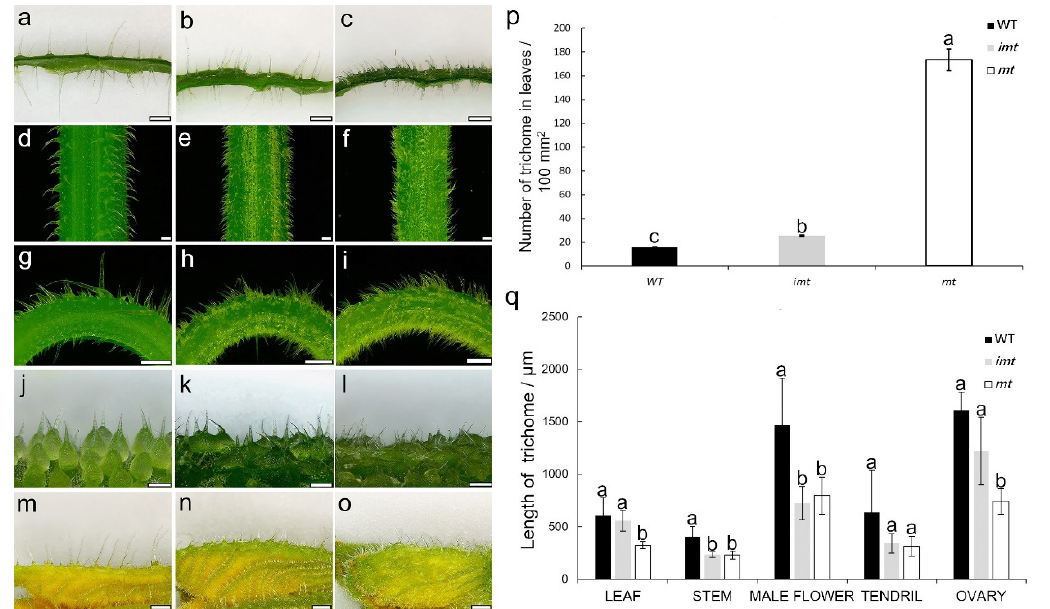
Figure 1. Trichome phenotypic characterization of WT, mt mutant and their F 1 progeny. ( a , d , g , j , m ) CCMC (WT). ( b , e,h , k , n ) F 1 progeny crossed between CCMC and mt . ( c , f , i , l , o ) the mt mutant. Bar = 500 μ m in ( a – i ); bar = 750 μ m in ( j – l ); bar = 1 mm in ( m – o ). ( p ) The number of trichomes on leaves of the mutant, WT and their F 1 . ( q ) The length of trichomes of the mutant, WT and their F 1 . Letters above the bars indicate significant differences at p < 0.05.